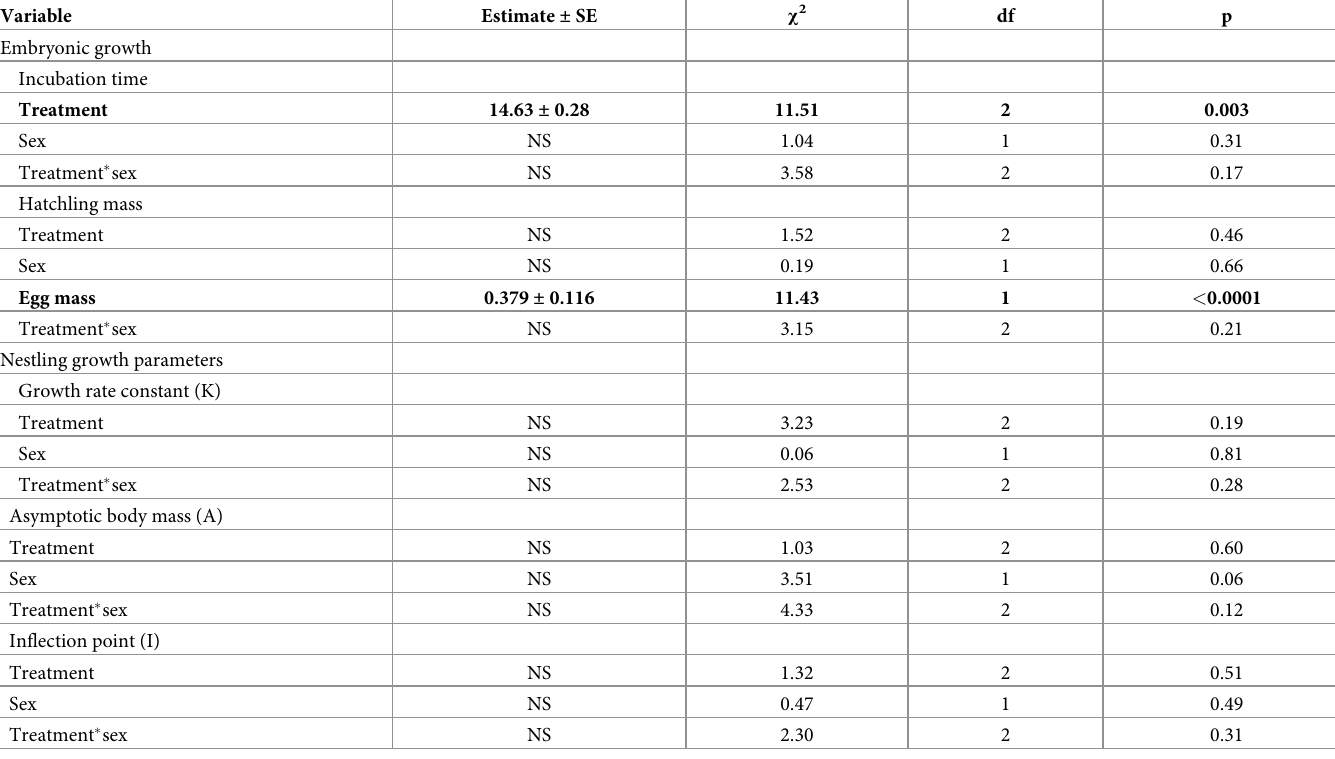
Table 2. Results of linear mixed effects models on incubation time, hatchling body mass and growth parameters, growth rate constant (K), asymptotic body mass (A) and inflection point (I) calculated from a logistic growth